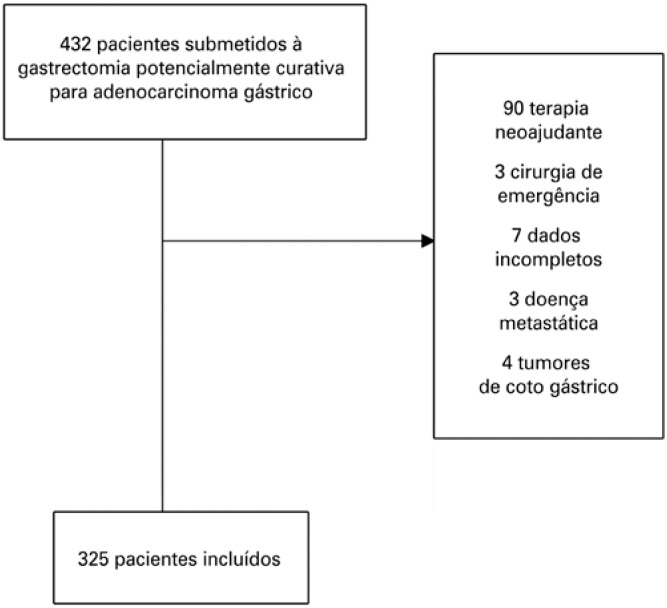
Fluxograma de critérios de inclusão e exclusão